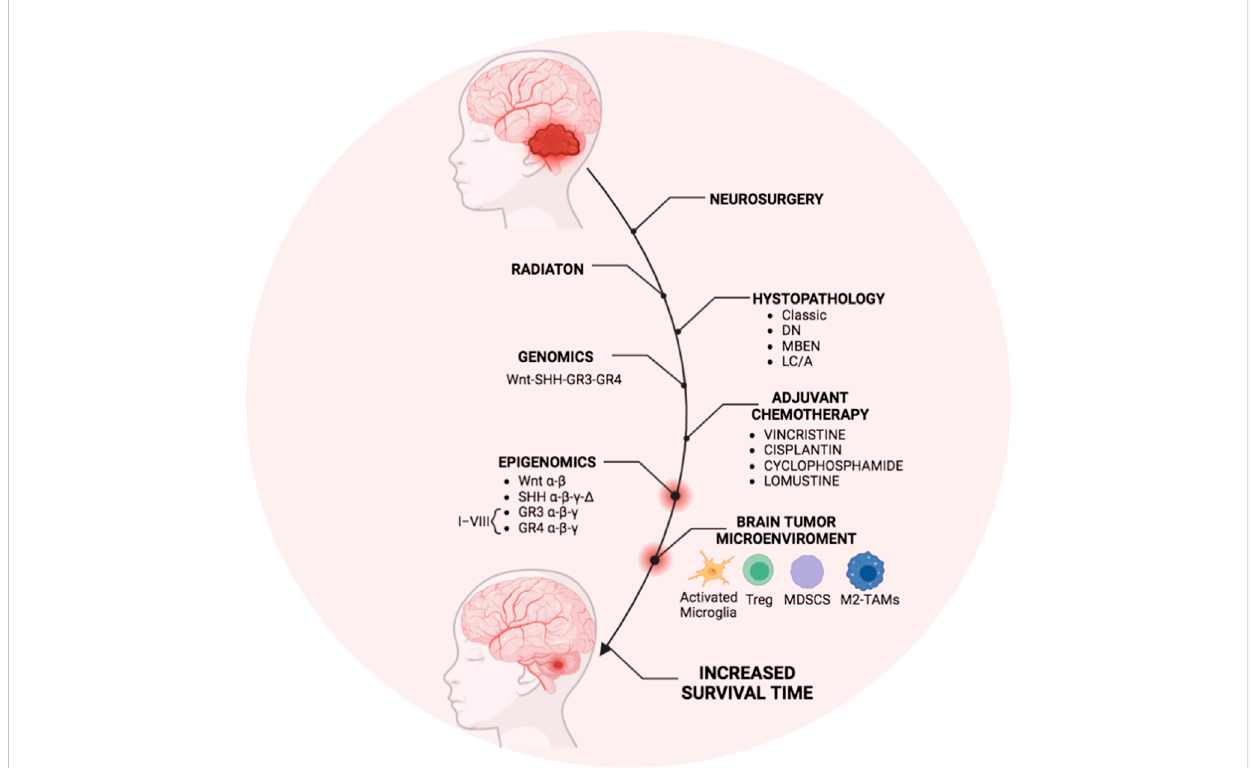
FIGURE 2 Overview of MB treatment modalities in the last decade. The scheme represents the therapeutic strategy for MB currently used in clinics that generally includes the surgical resection followed by irradiation and cycles of adjuvant chemotherapy mostly based on molecular and histopathological features. Recently, genomics and epigenomics approaches have clari fi ed the molecular risk assessment among the molecular MB subgroups. Furthermore, the presence of immunosuppressive immune cells in fi ltrating the BTME in MB patients has been also reported. Thus, genetic and epigenetic modulators targeting the immune cells within the BTME could obtain the most ef fi cient and personalized therapy to increase the patient survival timing. The fi gure was created via